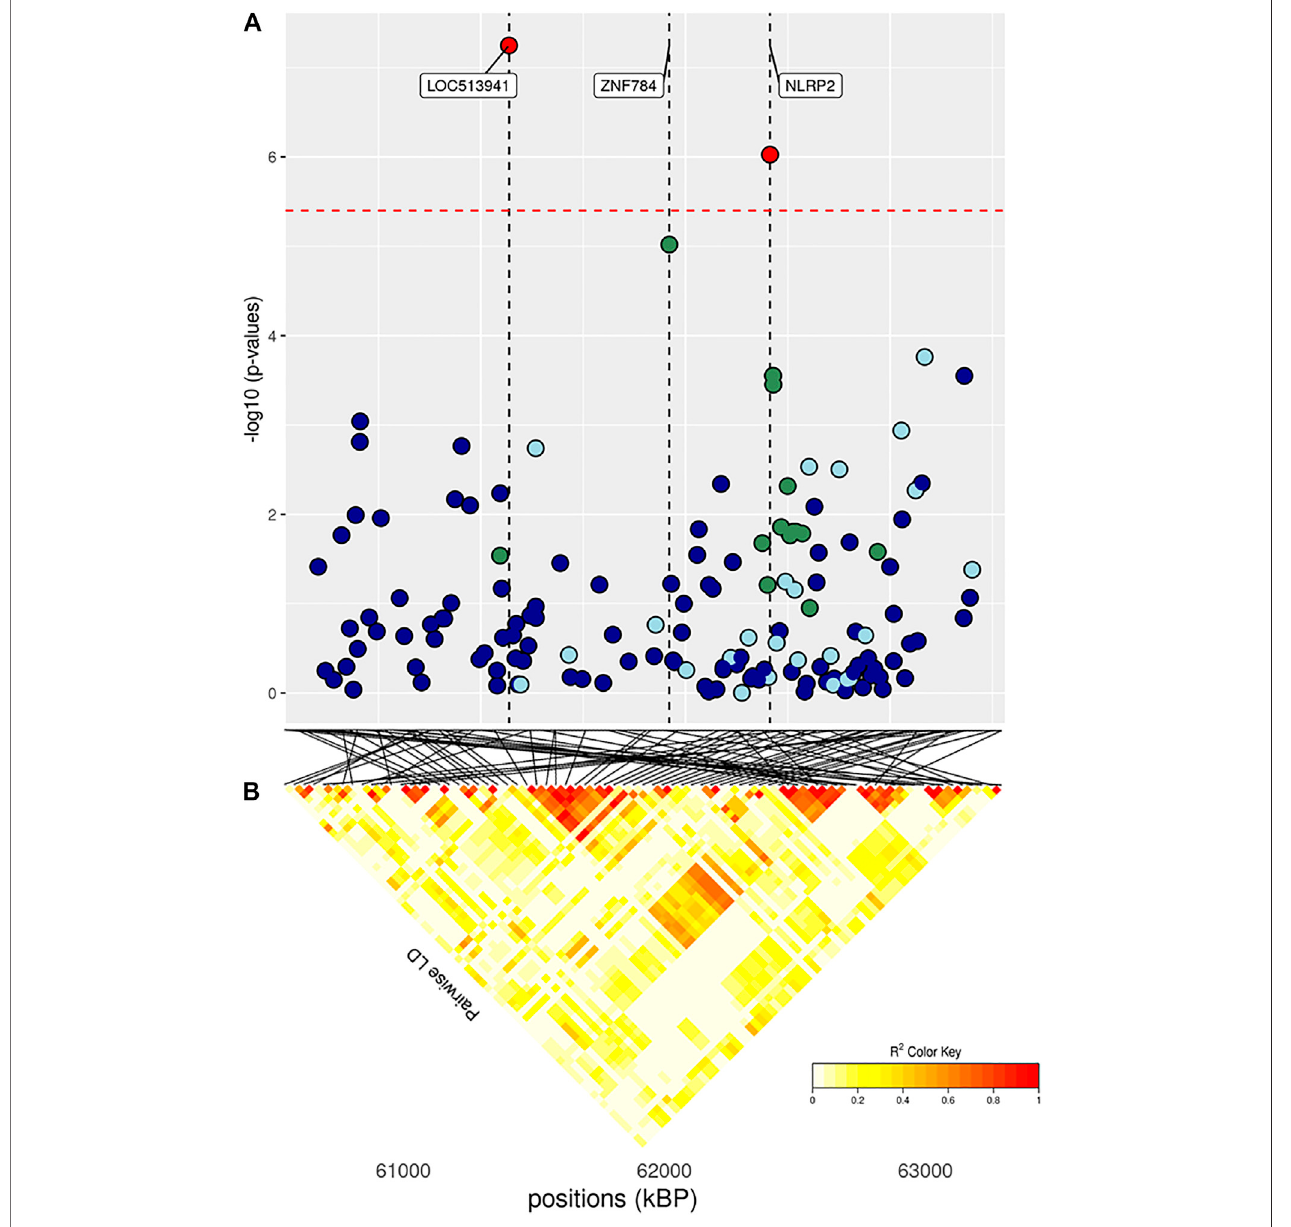
FIGURE 6 | (A) Localized linkage disequilibrium analysis of DP. Manhattan plots displaying the level of signi fi cance (y-axis) over genomic positions (x-axis) in a window of 0.5 Mb upstream and downstream of the most signi fi cantly SNP. Vertical line represents the position of candidate genes LOC513941 , ZNF784 and NLRP2 . Different colors are used to represent the pairwise LD with the closest signi fi cant SNPs: blue < 0.2; light blue < 0.4; green < 0.6; yellow < 0.8 and red > 0.8. (B) the represents Linkage disequilibrium present of that area.